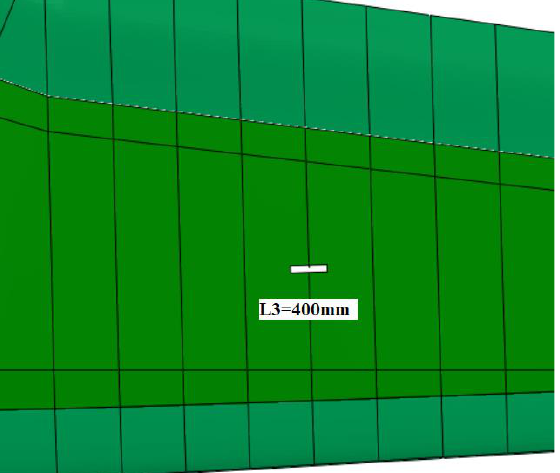
Figure 9. Illustration of the damage cutting through a single rib component.